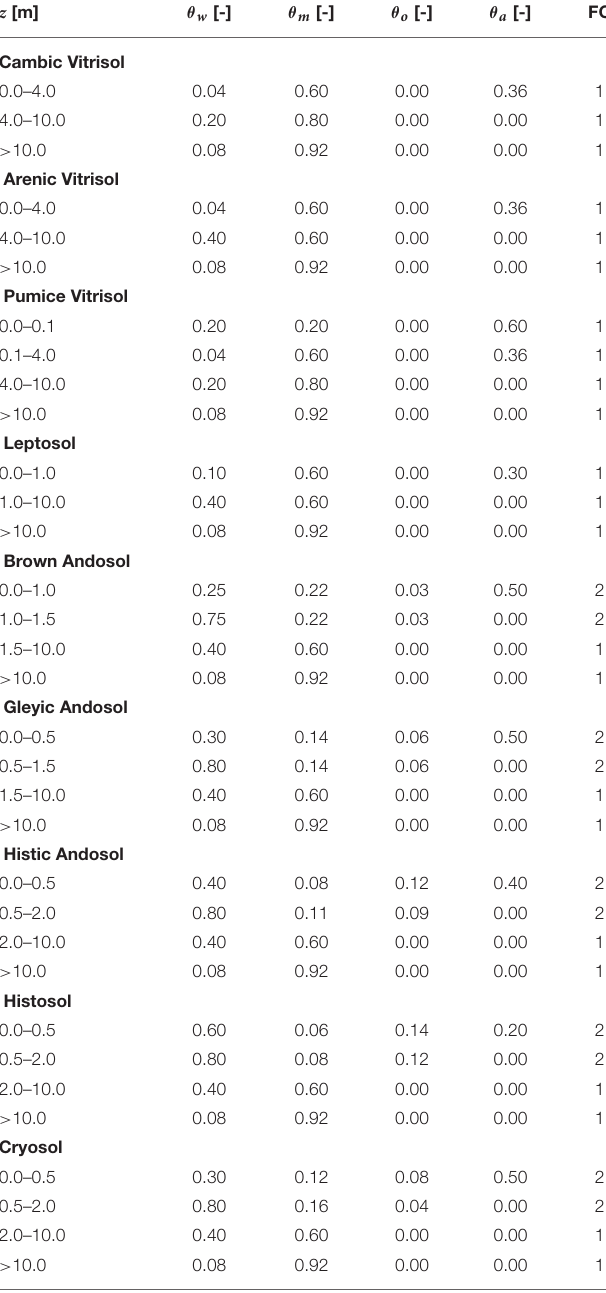
TABLE 1 | Assumed depths of subsurface layers, along with volumetric fractions of the soil constituents and type of freeze curve (FC) for each layer: 1, sand and 2,